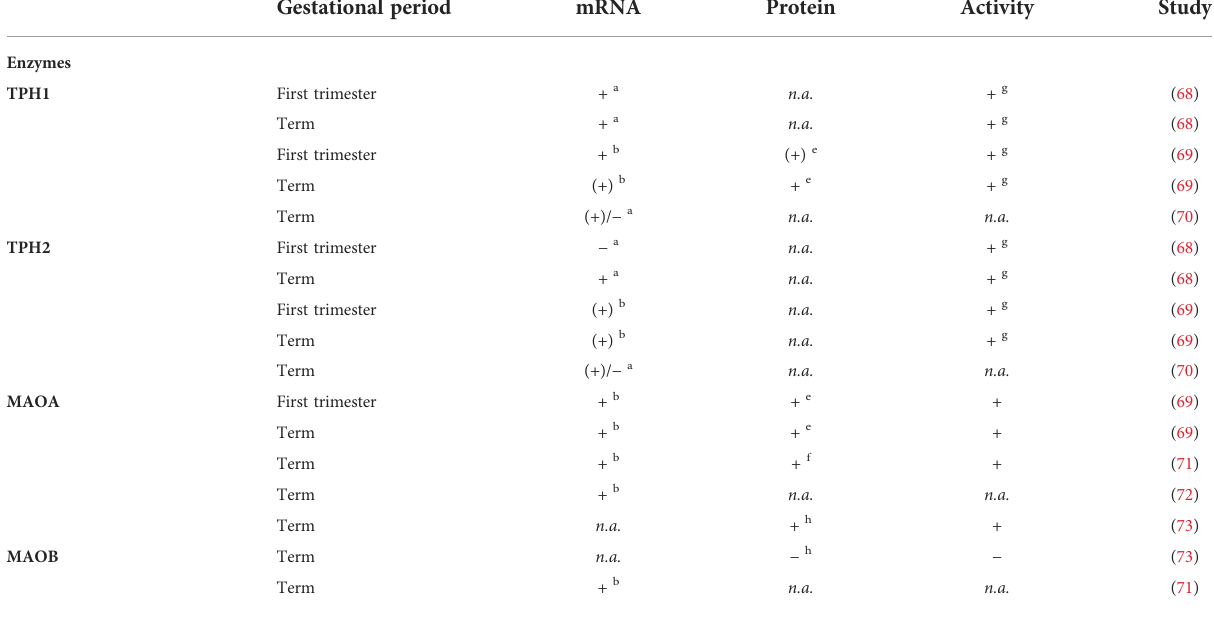
TABLE 1 Presence of components of the serotonin system in homogenates of human placental tissue. Gestational period mRNA Protein Activity Study